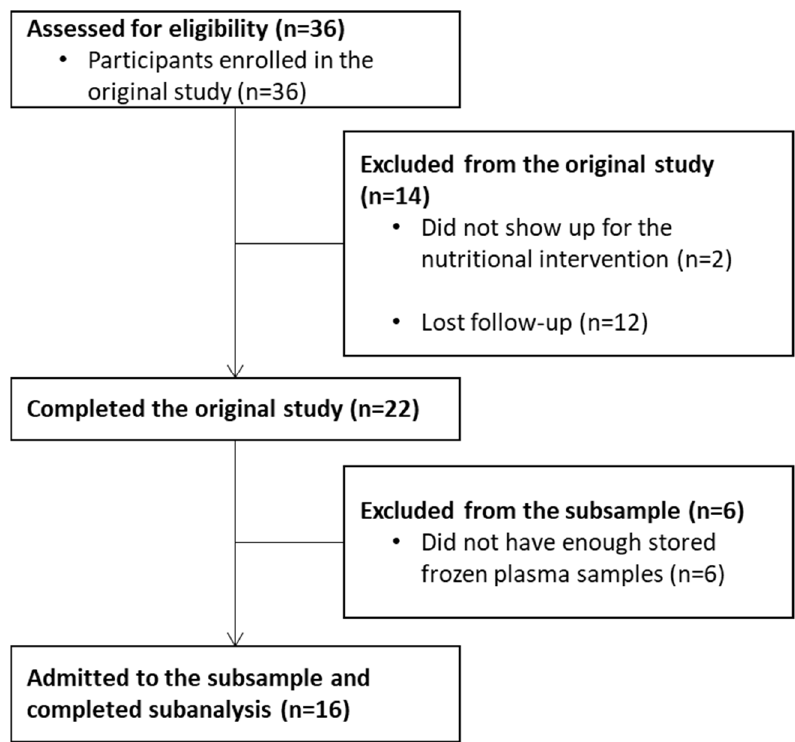
Figure 1. CONSORT flow diagram of the subsampling process.